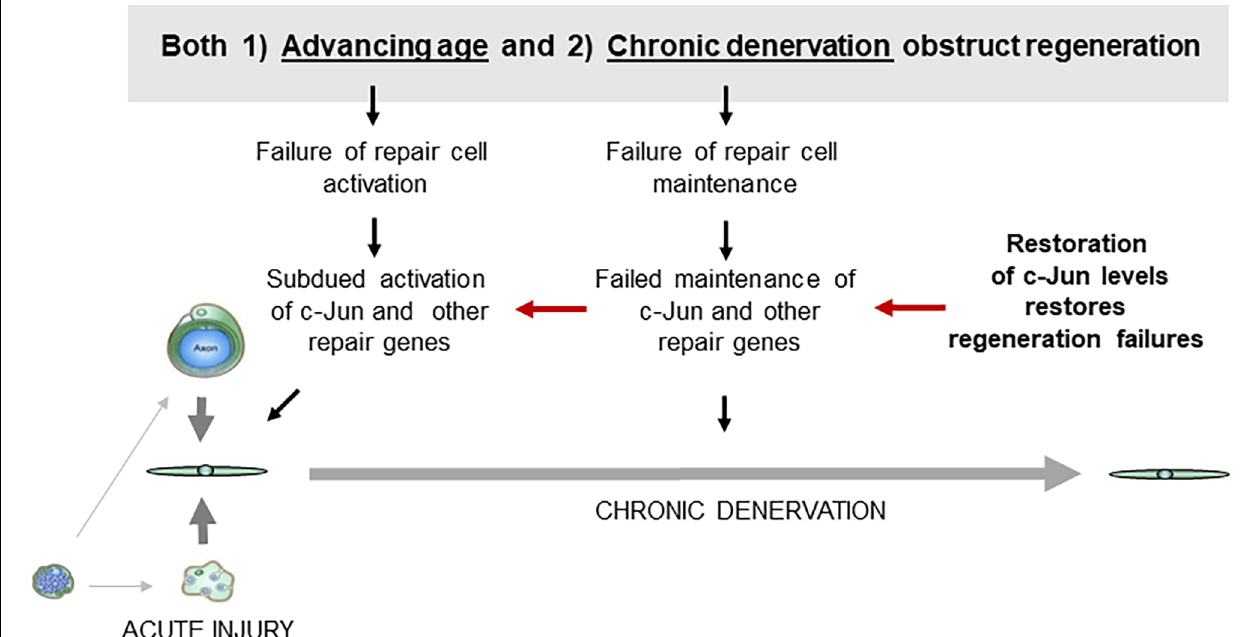
FIGURE 8 | Failure of c-Jun expression in repair cells prevents successful regeneration. Defective c-Jun expression in repair cells is an important factor in regeneration failures associated with both aging and chronic denervation. Because correcting defective c-Jun levels corrects regeneration deficits, pathways that regulate c-Jun levels are a potential target for treatments for improving nerve regeneration (for references see